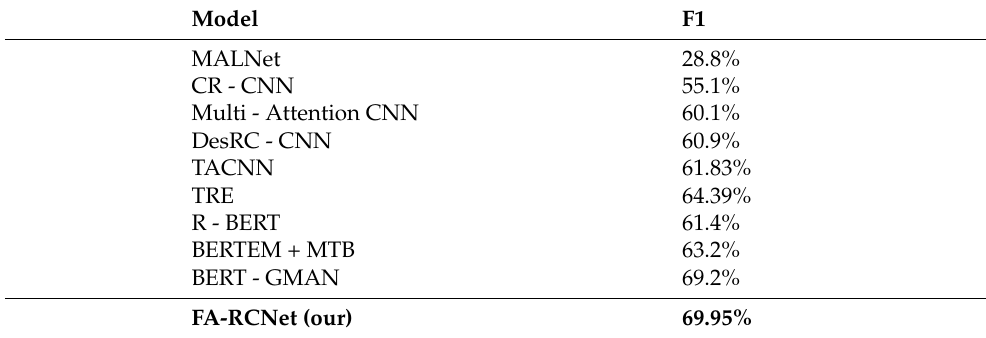
Table 7. A comparison test with other relational classification models on the KBP37